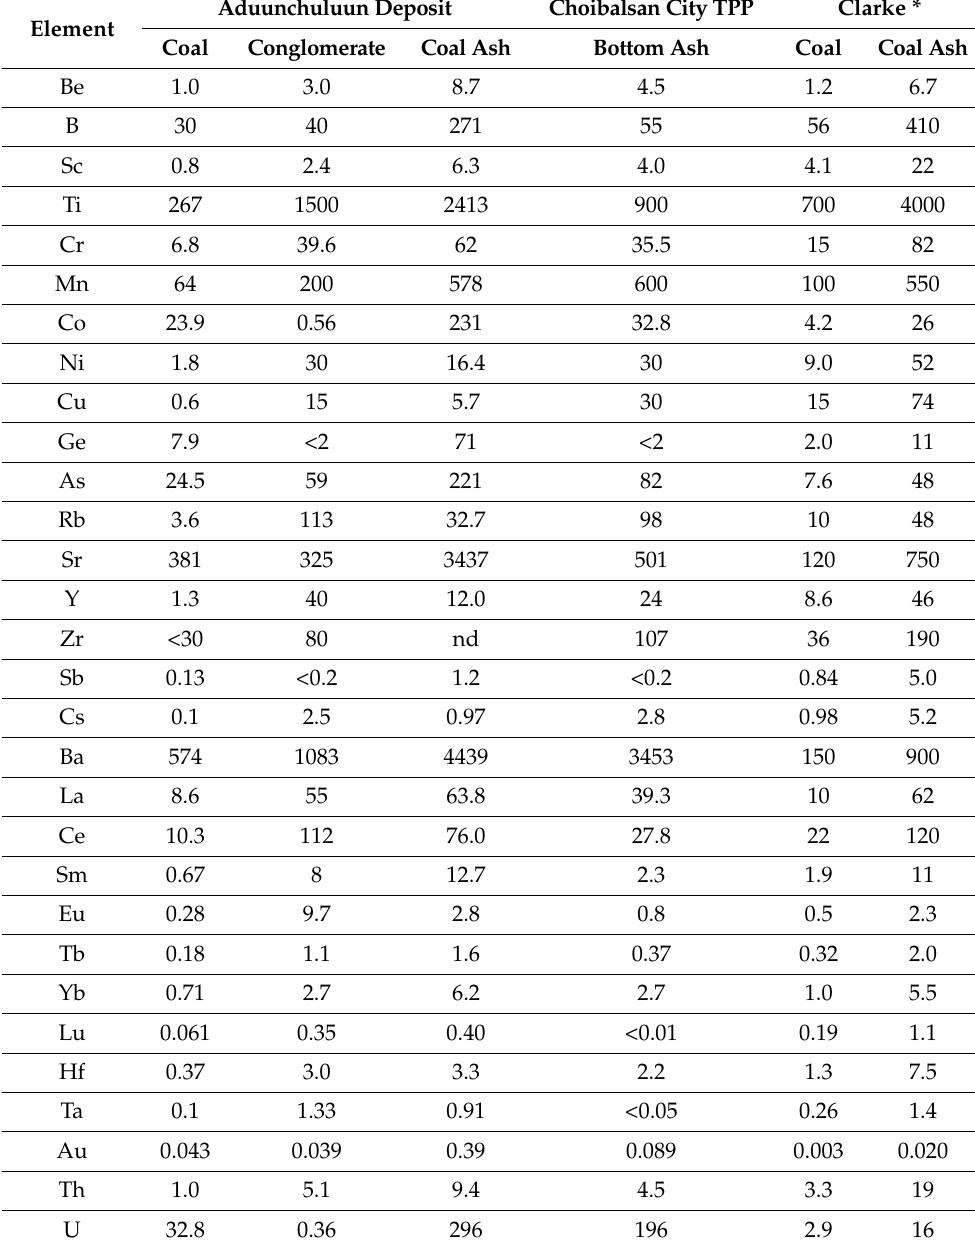
Table 4. The average content of selected trace elements in coal, coal ash, and coal-bearing rocks of the Aduunchuluun deposit (ppm; analyzed by INAA and ICP-MS, from Arbuzov and Mashenkin [63]). Aduunchuluun Deposit Choibalsan City TPP Clarke * Element Coal Conglomerate Coal Ash Bottom Ash Coal Coal